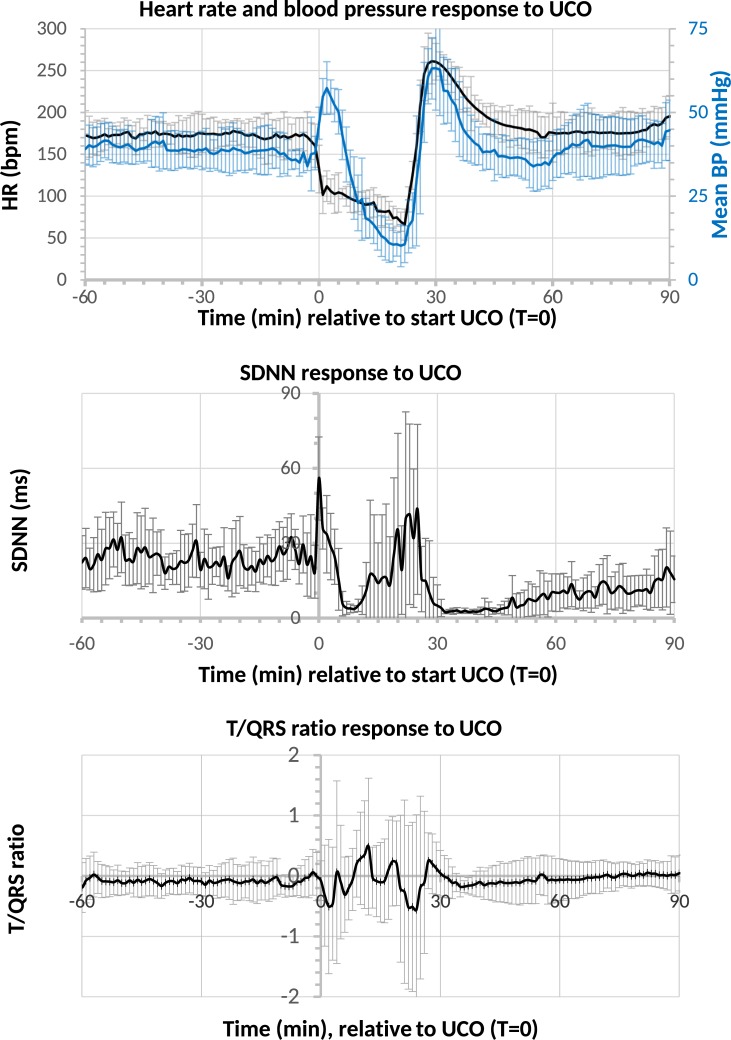
Blood pressure and heart rate response during normoxemia and hypoxemia.Mean arterial blood pressure (BP), heart rate (HR, beats per minute, bpm), heart rate variability (expressed as SDNN, ms) and T/QRS ratio during baseline, UCO (T = 0–25 minute) and reperfusion of all subjects. The mean values are shown with 95% confidence intervals. Note the marked bradycardia and initial hypertension directly after cord occlusion; during occlusion a sustained bradycardia and progressive hypotension was observed. After umbilical cord occlusion, the reperfusion period showed a marked decrease in SDNN compared to the baseline period.